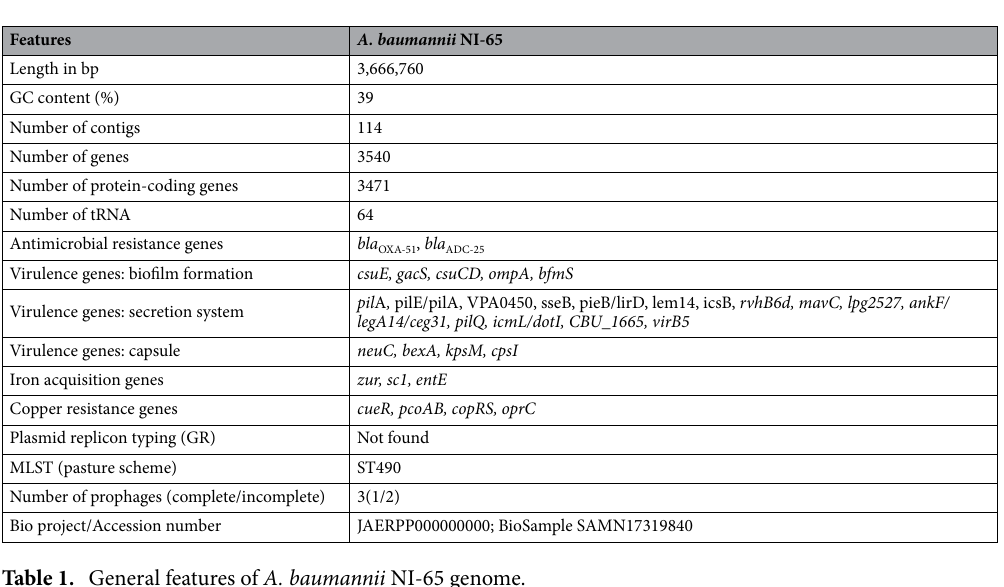
Table 1. General features of A. baumannii NI-65